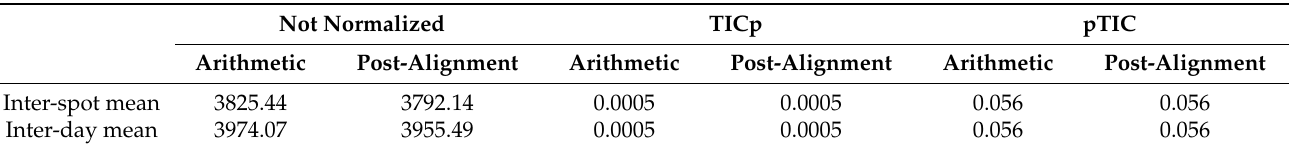
Table 2. Arithmetic and post-alignment means at spot- and day-level without normalization and with the two different normalization methods applied—before (TICp) and after (pTIC) finding peaks. Not Normalized TICp pTIC